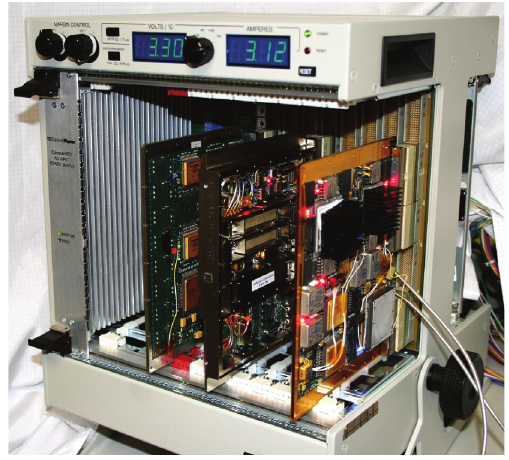
Figure 10: T-SDR modules loaded in a compact-PCI test chassis. The use of commodity compact-PCI chassis allow for cheap and e ffi cient development cycles. Shown right to left are RTSP, DCR, and SVIM in COTS cPCI test chassis.